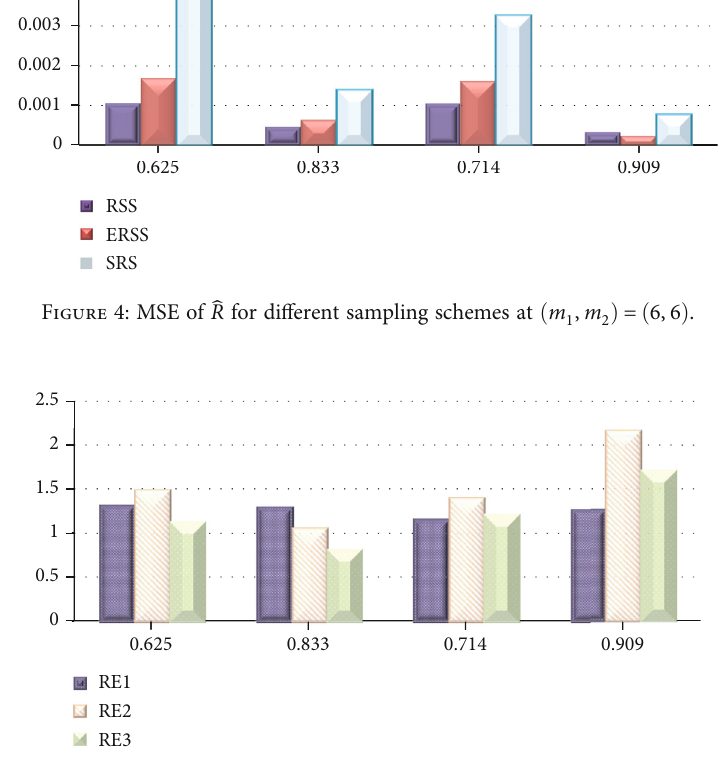
Figure 5: Relative e ffi ciency of ̂ R for di ff erent sampling schemes at ð m